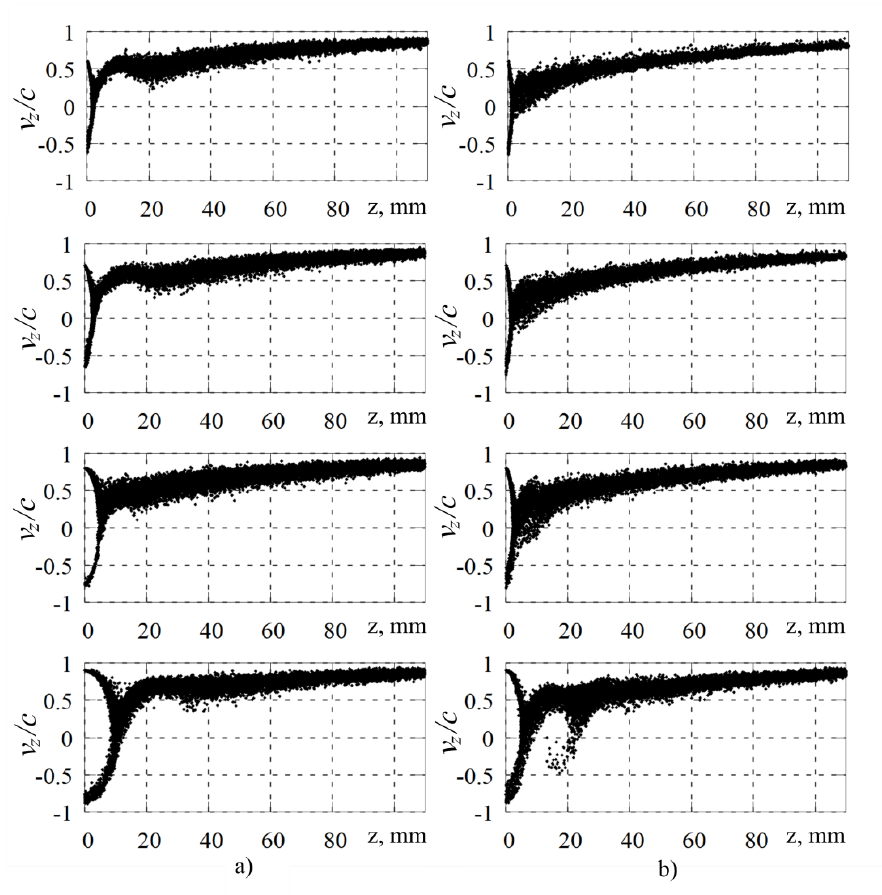
Fig. 6. Projections of the phase space of the electron beam in the (v z , z) plane with increasing beam velocity and constant space charge density a) without taking into account the image field b) with images. System parameters: ρ = 0.443 C / m 3 (corresponds to 10 kA at 0.8 c), B = 1 T, r = 5.48 mm, N = 30, Δ t = 1 ps, t = 600 ps. The velocity takes the values v = 0.6 c, 0.7 c, 0.8 c, 0.9 c (from top to